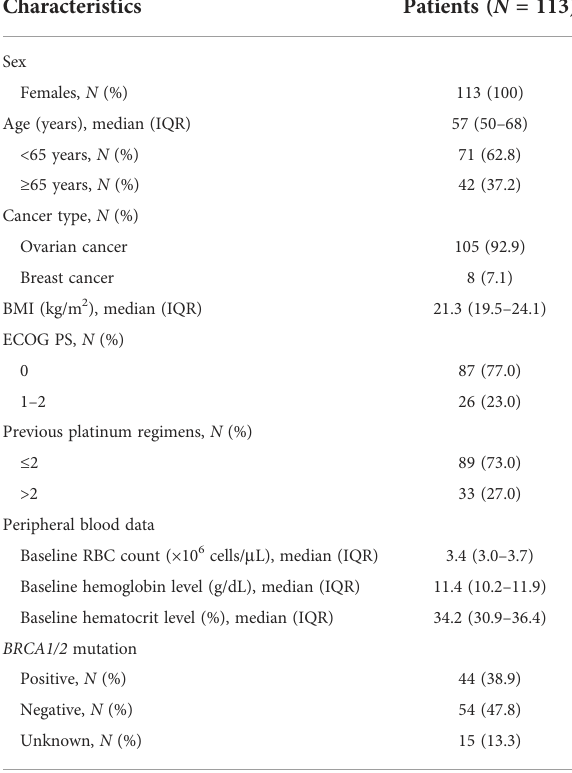
TABLE 1 Baseline clinical and demographic characteristics of